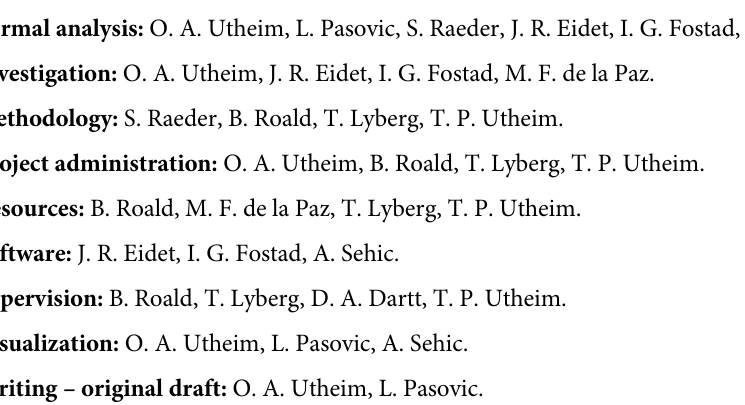
S5 Table. ImageJ area measurements based on Rhodamine stained culture images. Sample names with uneven numbers (grey background) represent large (3 mm) explants. Even num- bers (white background) mean small (1 mm) explants. S6 Table. Desmosomes per length based on transmission electron microscopy micro- graphs. Sample names with uneven numbers (grey background) represent large (3 mm) explants. Even numbers (white background) mean small (1 mm) explants. S7 Table. Hemi- desmosomes per length based on transmission electron microscopy micrographs. Sample names with uneven numbers (grey background) represent large (3 mm) explants. Even numbers mean small (1 mm)